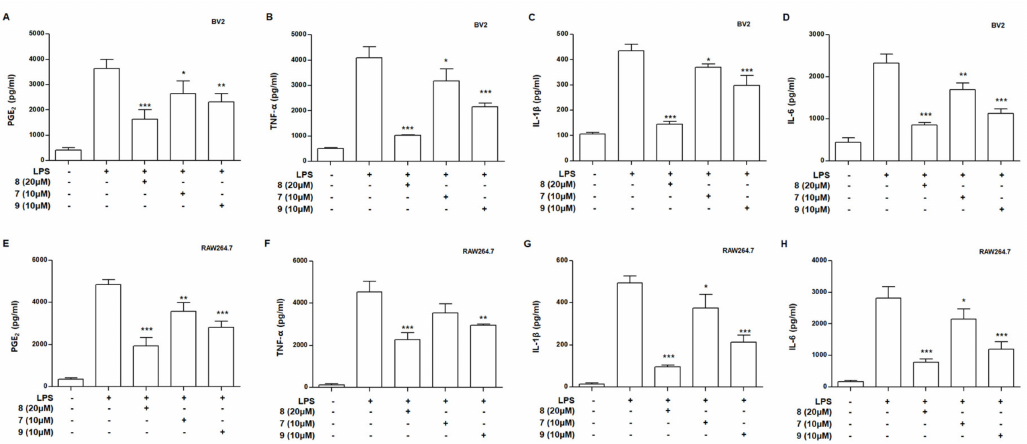
Figure 5. Effects of compounds 7–9 on levels of PGE 2 ( A , E ), tumor necrosis TNF- α ( B , F ), IL-1 β ( C , G ), and IL-6 ( D , H ) in lipopolysaccharide (LPS)-stimulated BV2 and RAW264.7 cells. Cells were pretreated for 3 h with indicated concentrations of compounds 7 – 9 and stimulated for 24 h with LPS (1 µ g/mL). PGE 2 assay and ELISA analysis were performed as described in Materials and Methods. Bars represent means ± standard deviation of three independent experiments. * p < 0.05, ** p < 0.01, *** p < 0.001 compared with LPS-treated